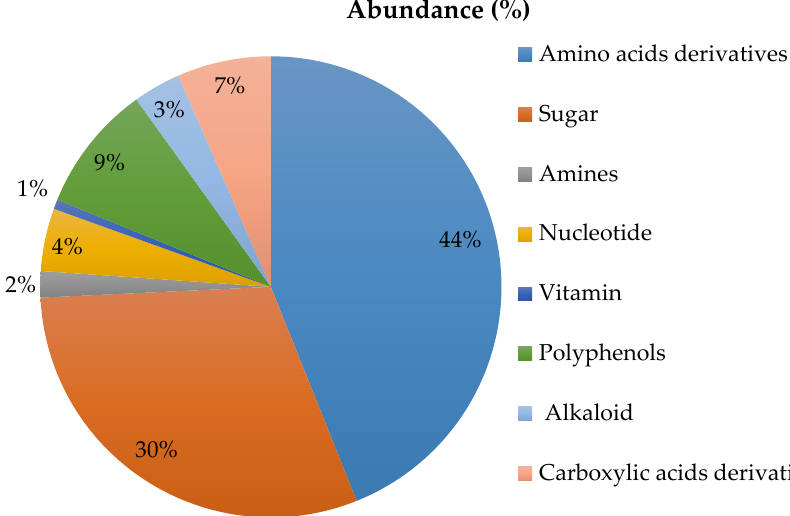
Figure 3. Mean abundance (%) of the chemical profiling in chocolates.